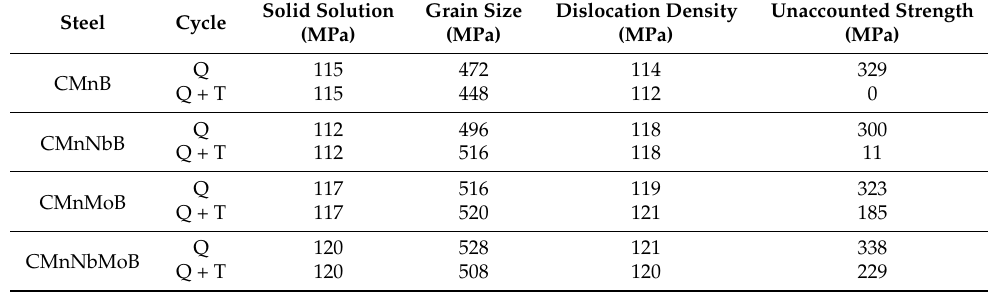
Table 5. Individual contributions of strengthening mechanism to yield strength.